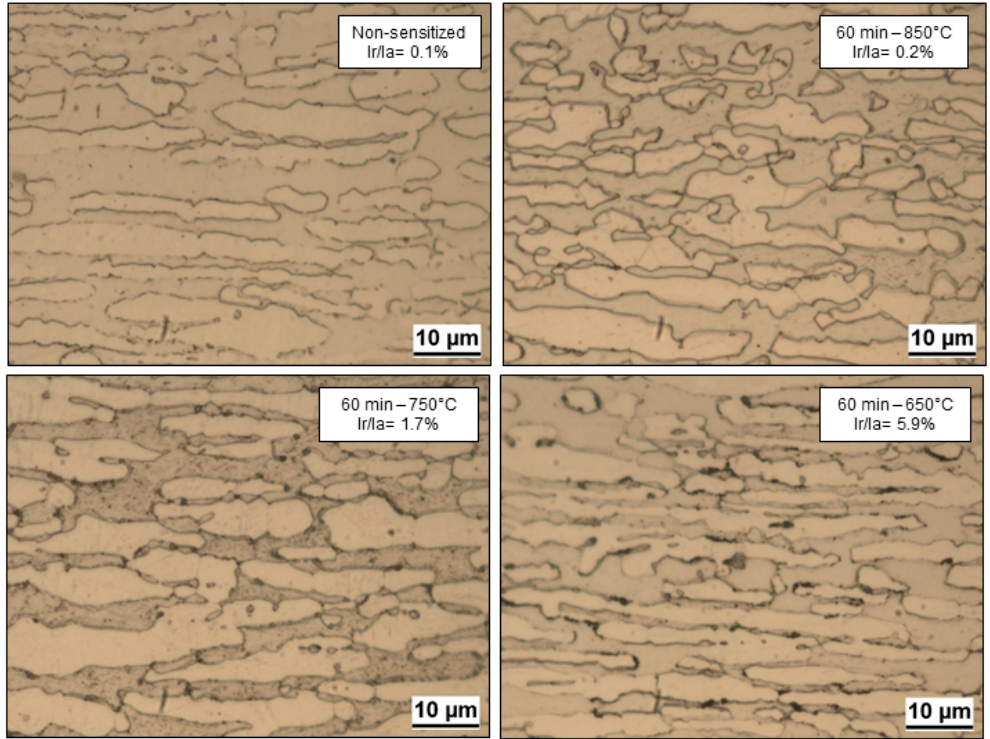
Figure 8. Optical microscope micrographs acquired on DSS 2304 electrodes after DL-EPR tests in 33% H2SO4 solution, at 20 °C, with 0.45% HCl addition.